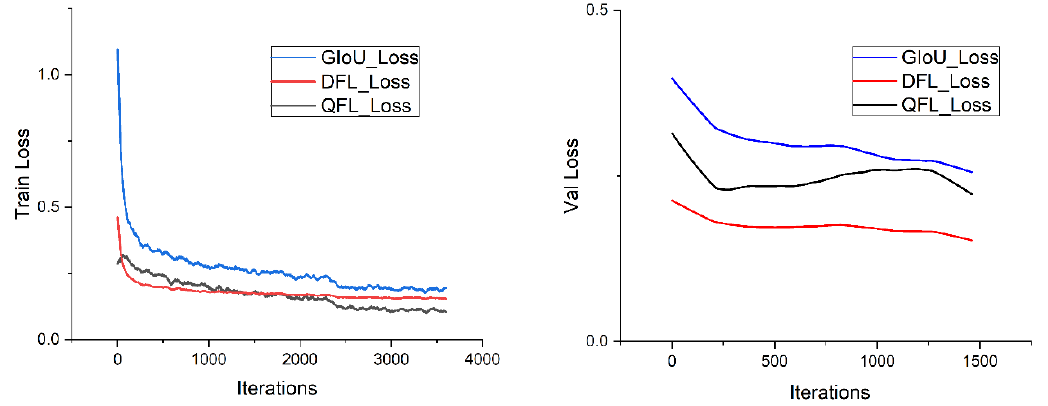
Figure 11. The loss curve of training and validation. As training loss stabilize, so does the validation loss.